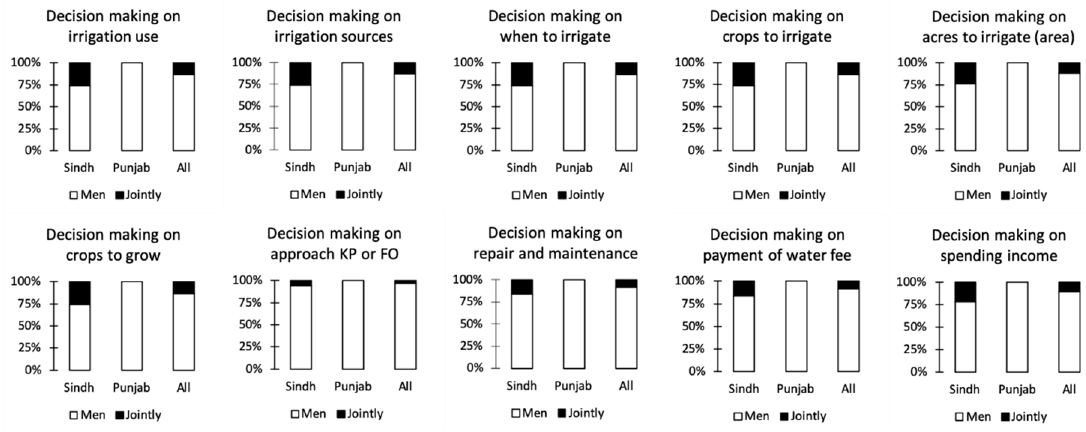
Figure 4. Decision-making in irrigation.